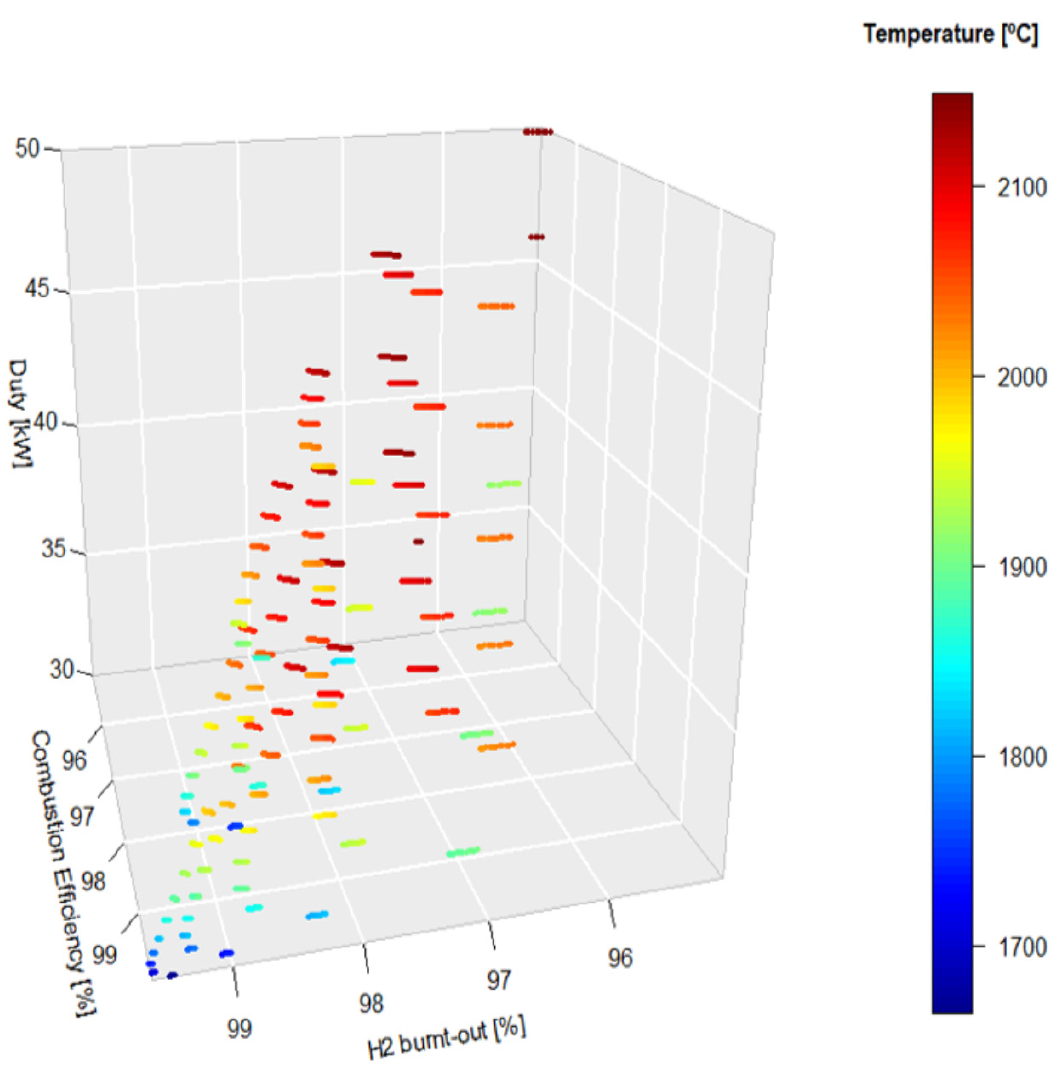
Figure 7. Operation variables results.